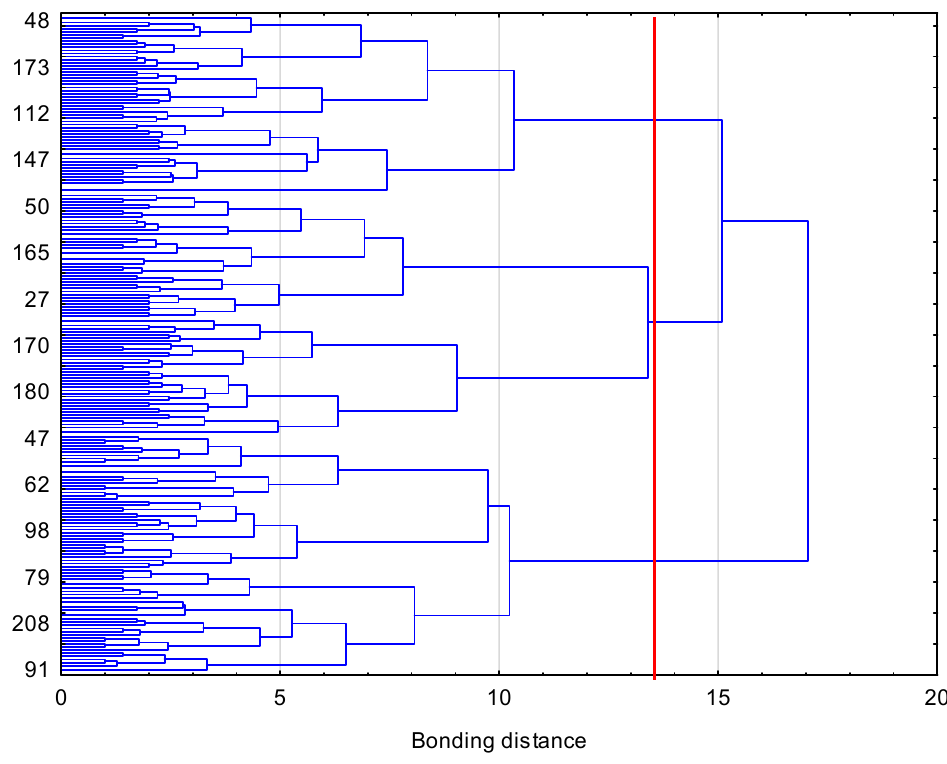
Figure 5. Dendrogram—a graph showing the clustering of individual 𝐴′ accident events in the subsequent calculation steps (cut-off place—Mojen’s rule [42]). Table 5. Characteristics of the obtained clusters—the share of a given cause in the group of accident events.